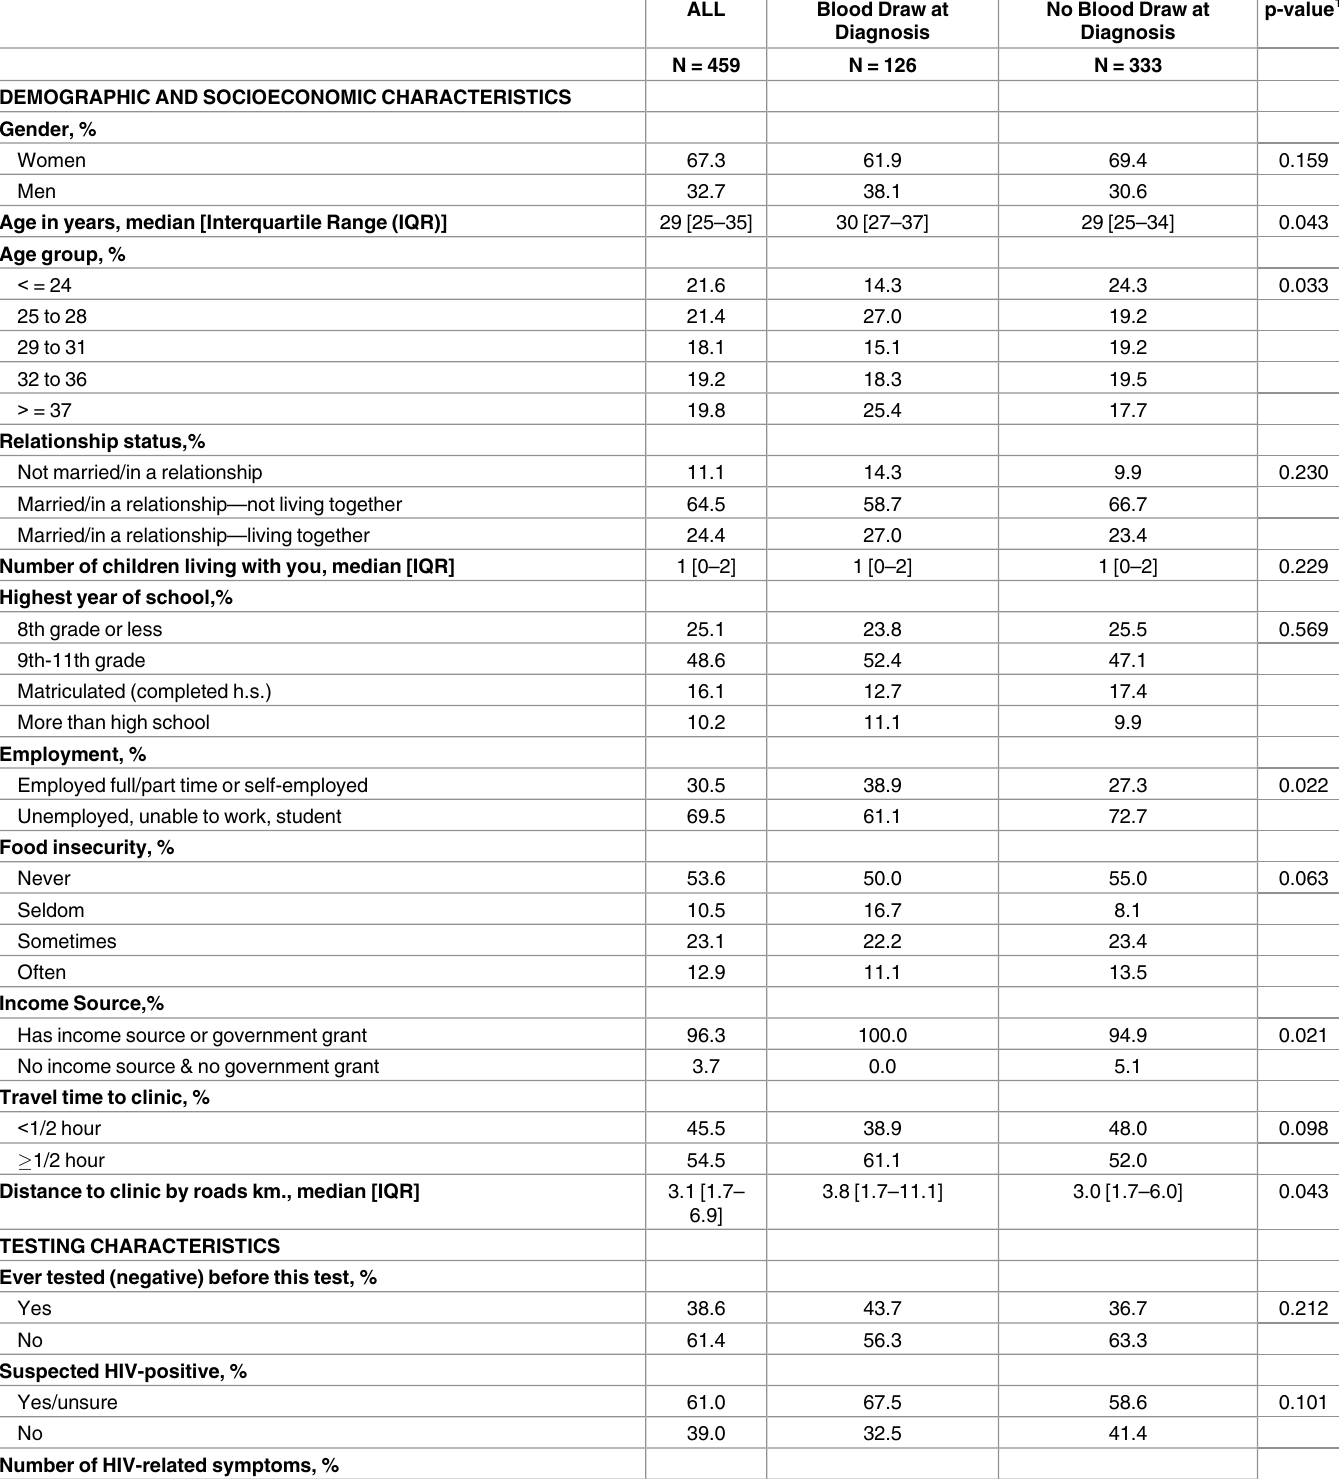
Table 1. Description of the population at baseline, overall and by whether blood was drawn for CD4+ count on the day of diagnosis, 459 newly- diagnosed HIV+ women and men, Durban, South Africa, 2010–2012. ALL Blood Draw at